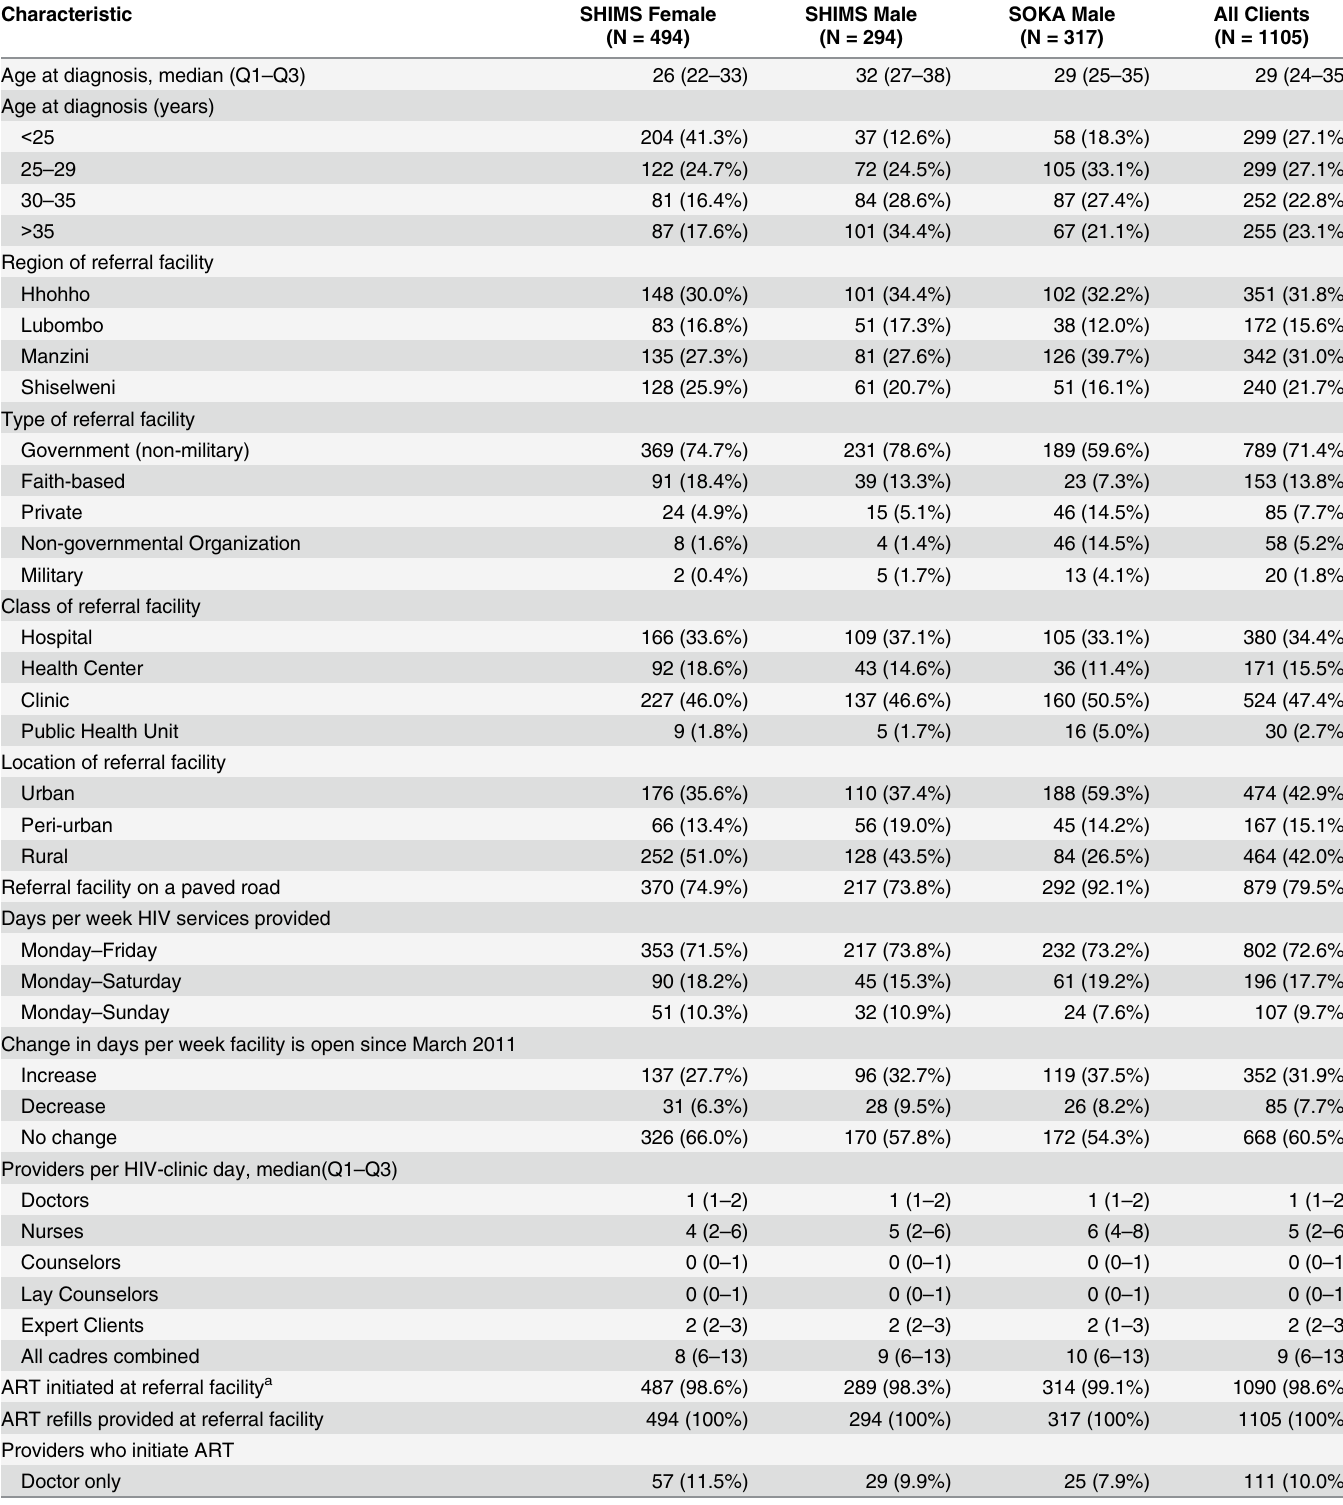
Table 1. Clisssent and referral facility characteristics, by study-gender